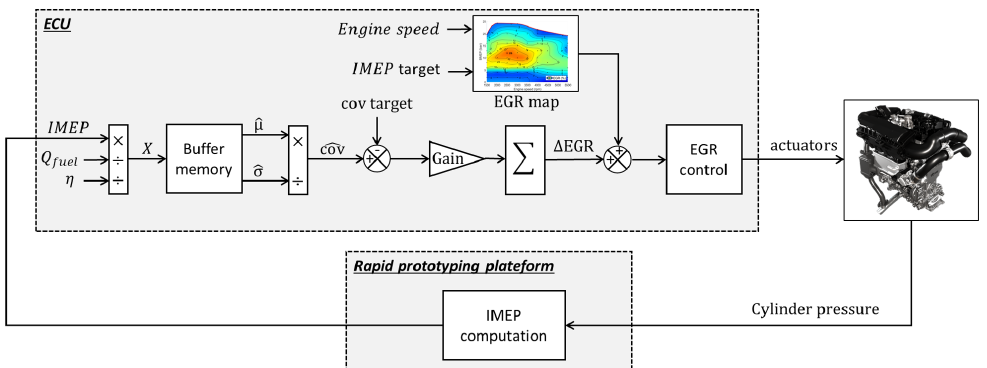
Figure 5. Engine control architecture.